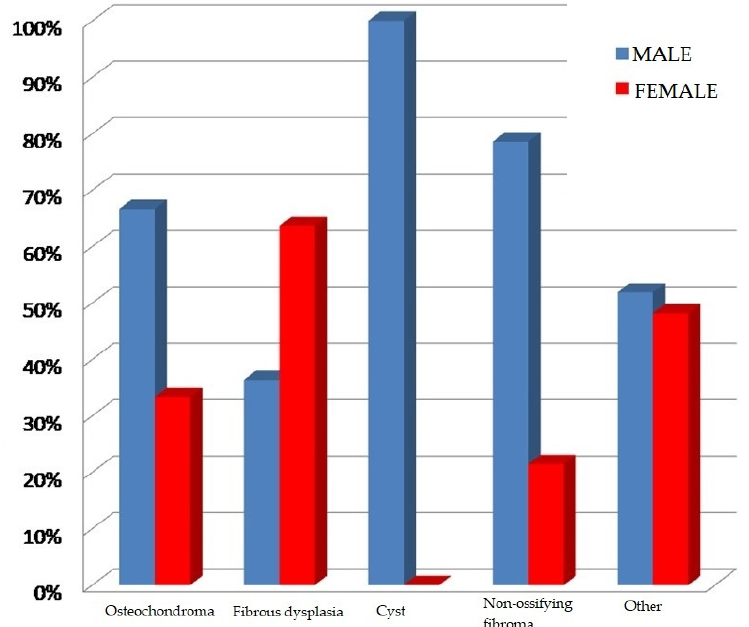
Figure 3. Sex distribution in the various histopathological diagnoses.